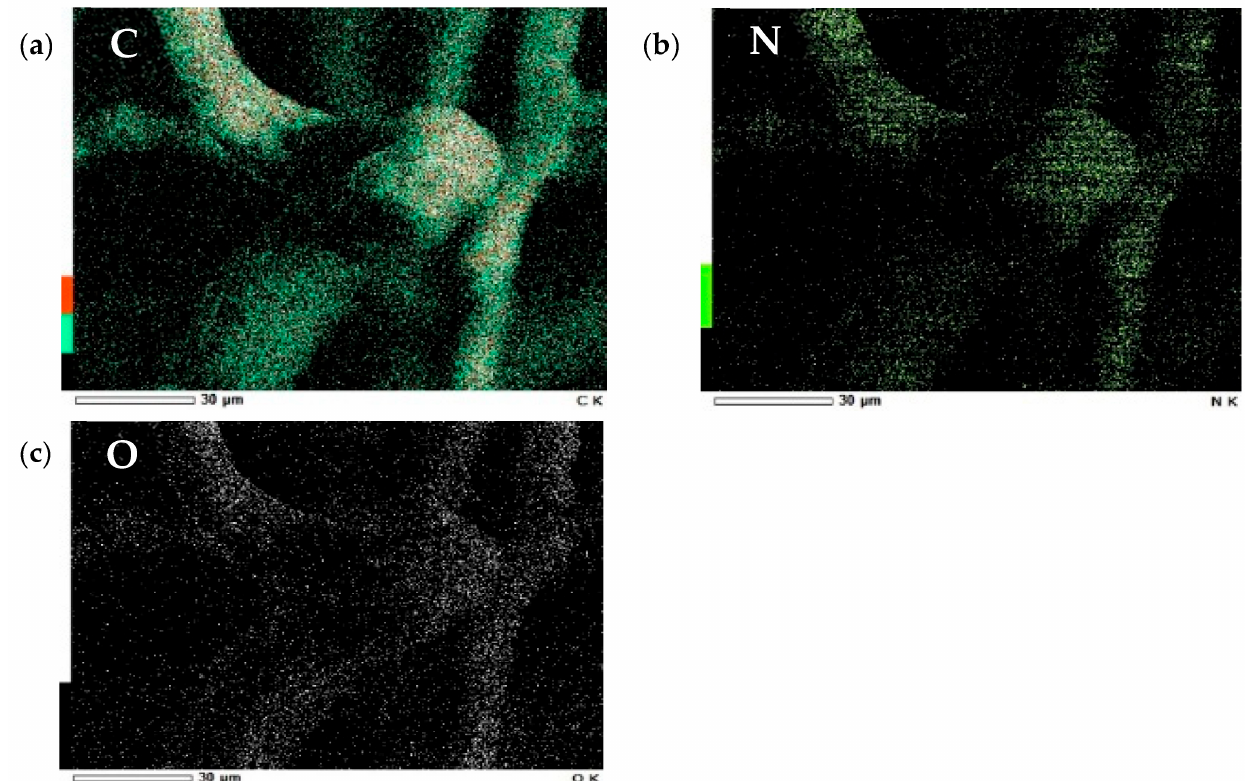
Figure 6. Element mapping images of modified cellulose [( a ): C, ( b ): N, ( c ): O].